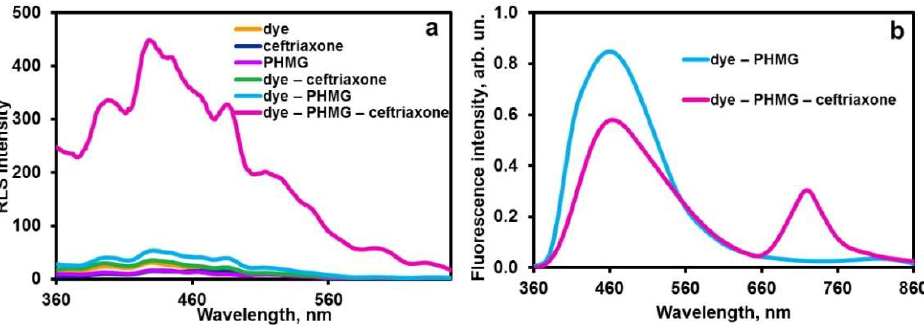
Figure 2. Rayleigh light scattering ( a ) and fluorescence ( b ) spectra of the system ceftriaxone–PHMG– dye. Conditions: pH 7.4 (7 mM phosphate buffer), 2.2 mM PHMG, 2.8 μM dye, 1.0 mM ceftriaxone.